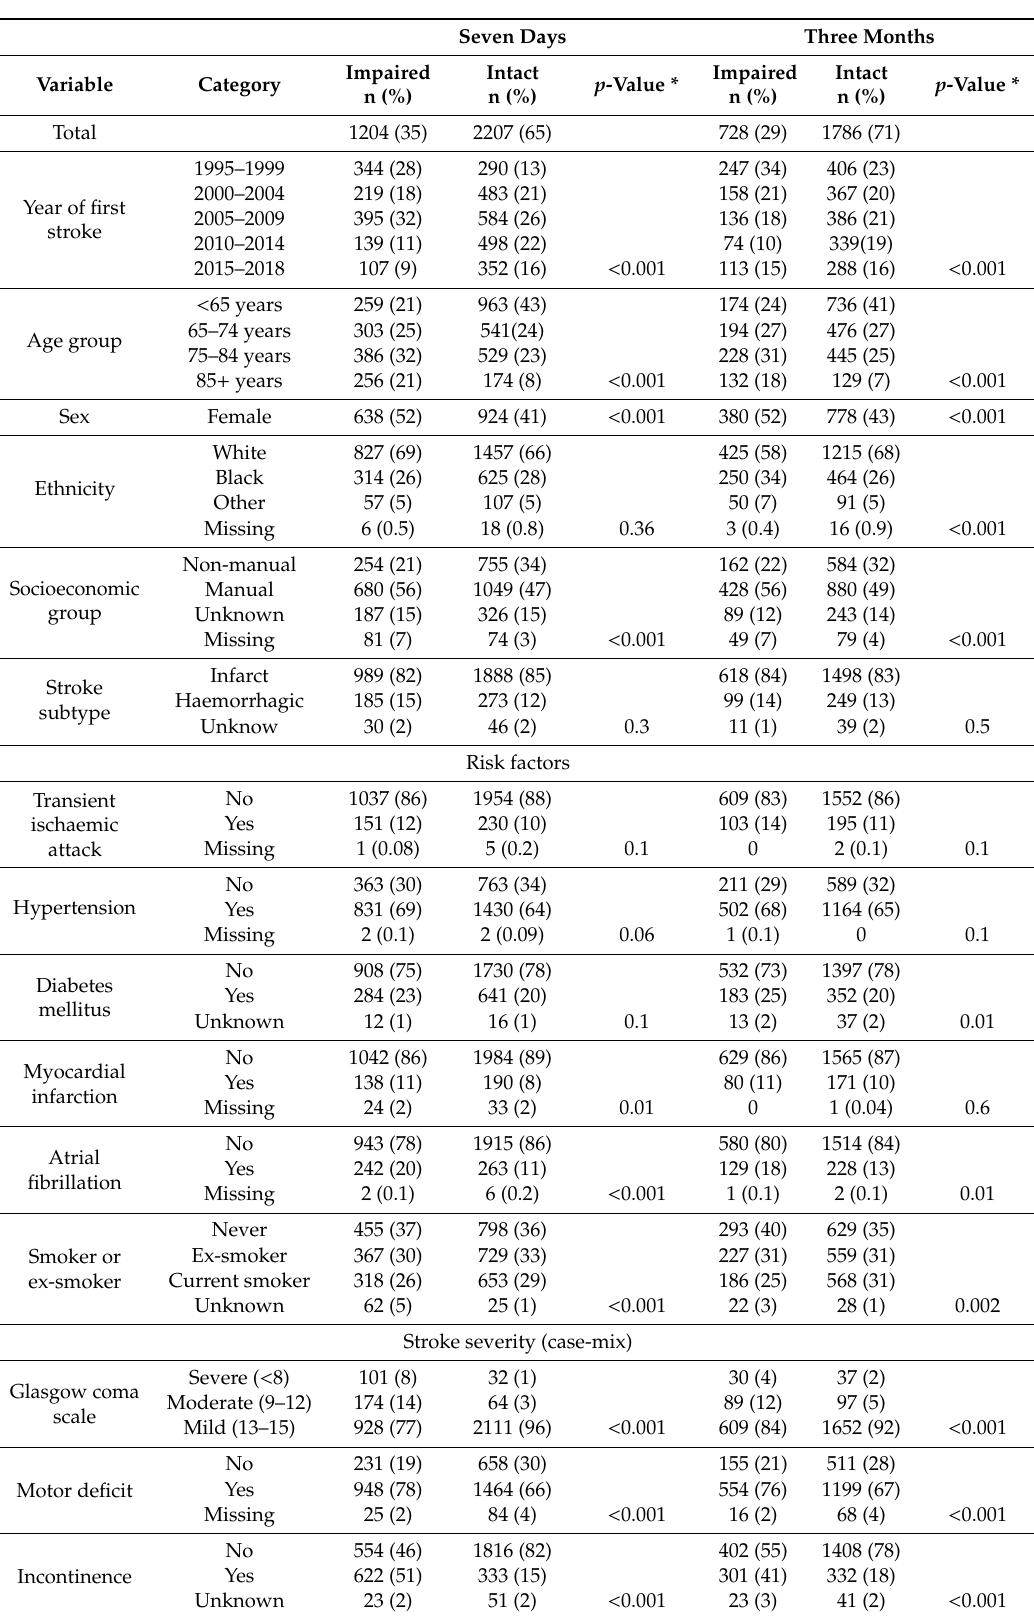
Table 1. Cognitive function assessment at stroke index and at three months after